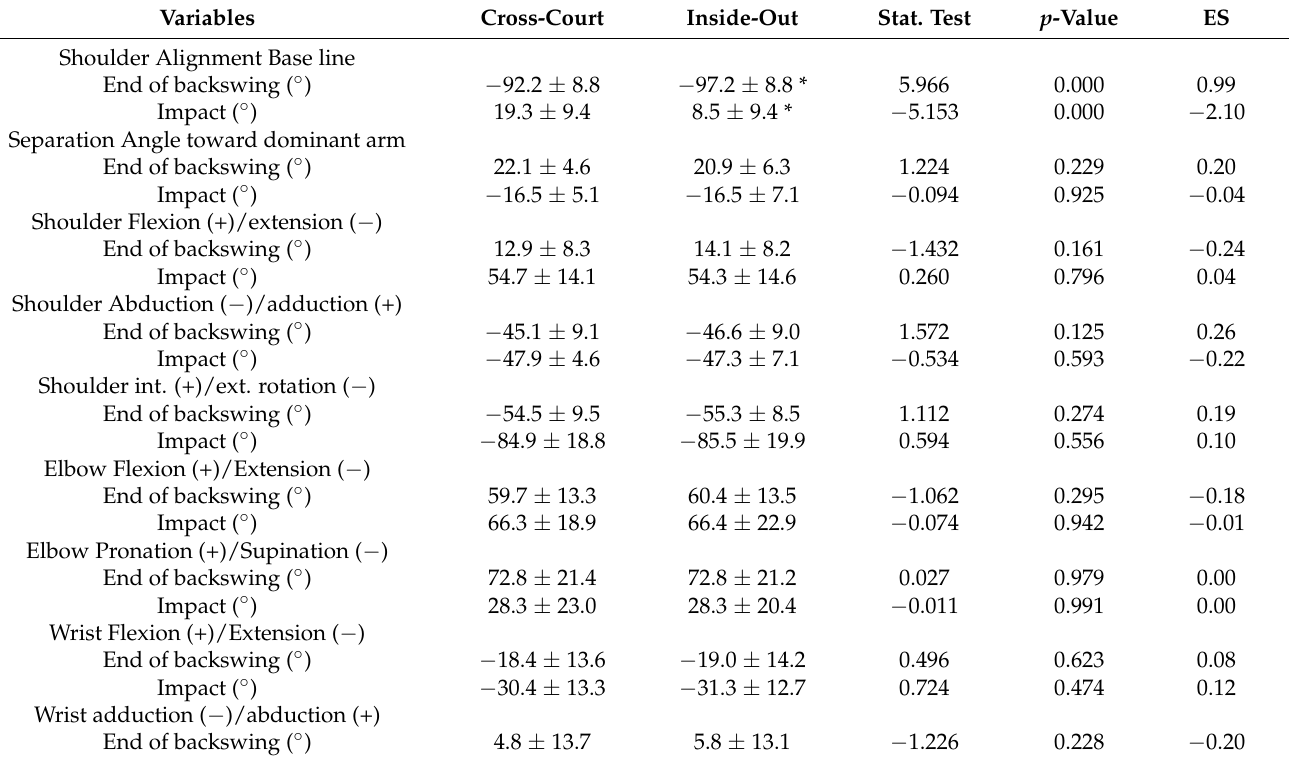
Table 1. Upper limb kinematic variables in cross-court and inside-out